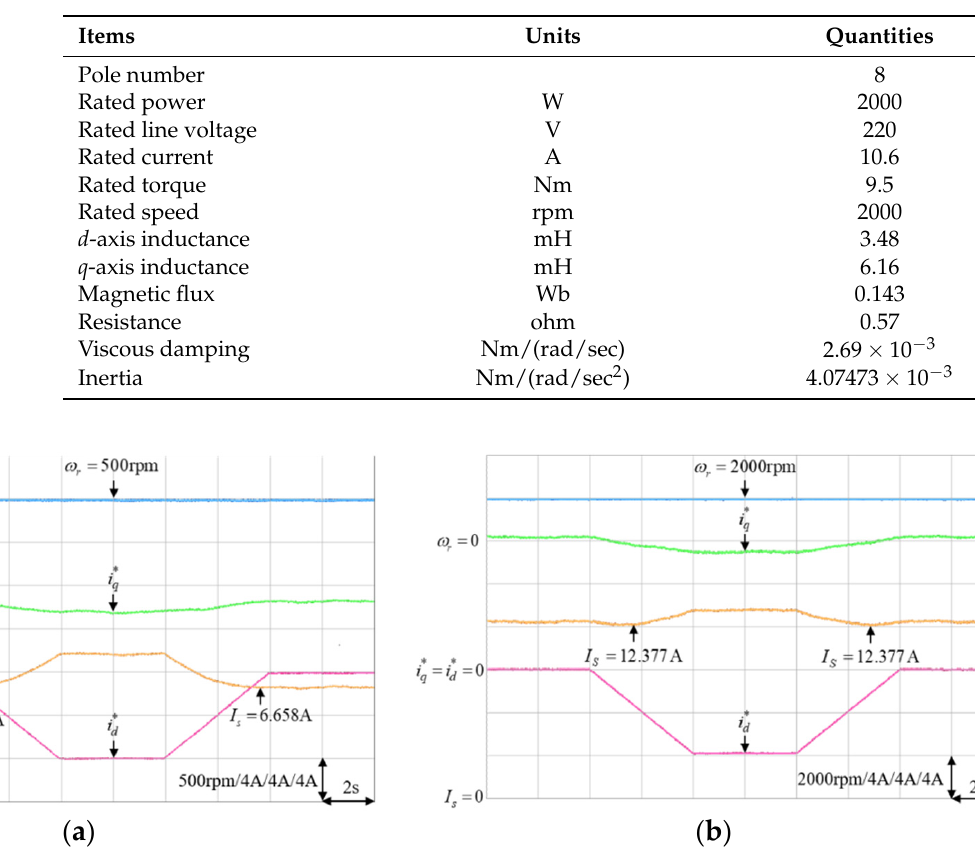
Figure 7. Photo of experimental setup.